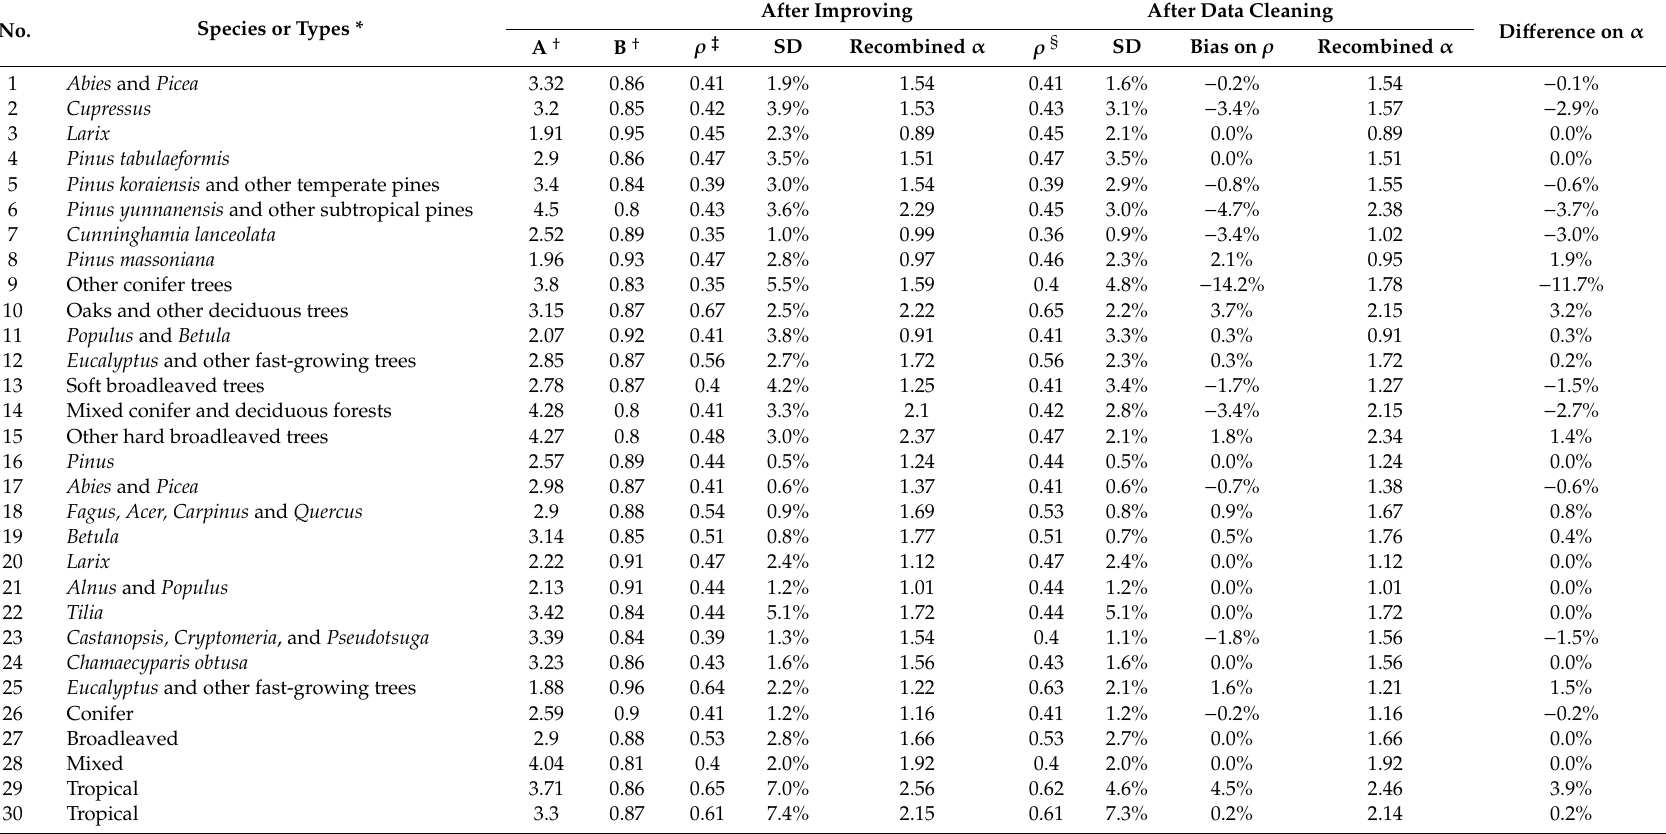
Table 1. Parameters in Equations (1)–(3) for 30 tree species and forest types across the